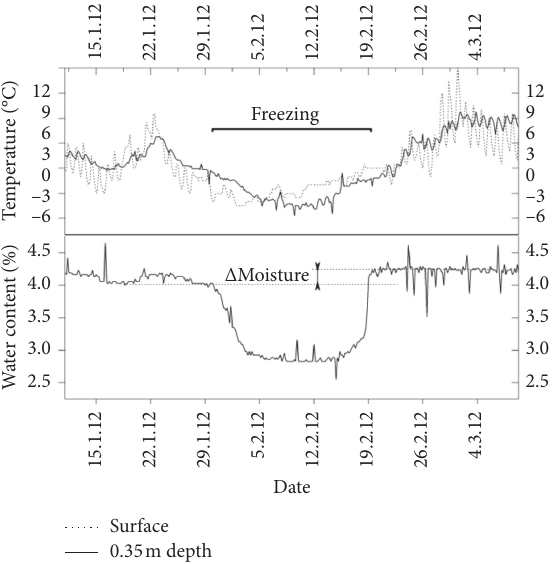
Figure 4: Continuous monitoring of moisture and temperature on the local road to detect negative effects of freezing.